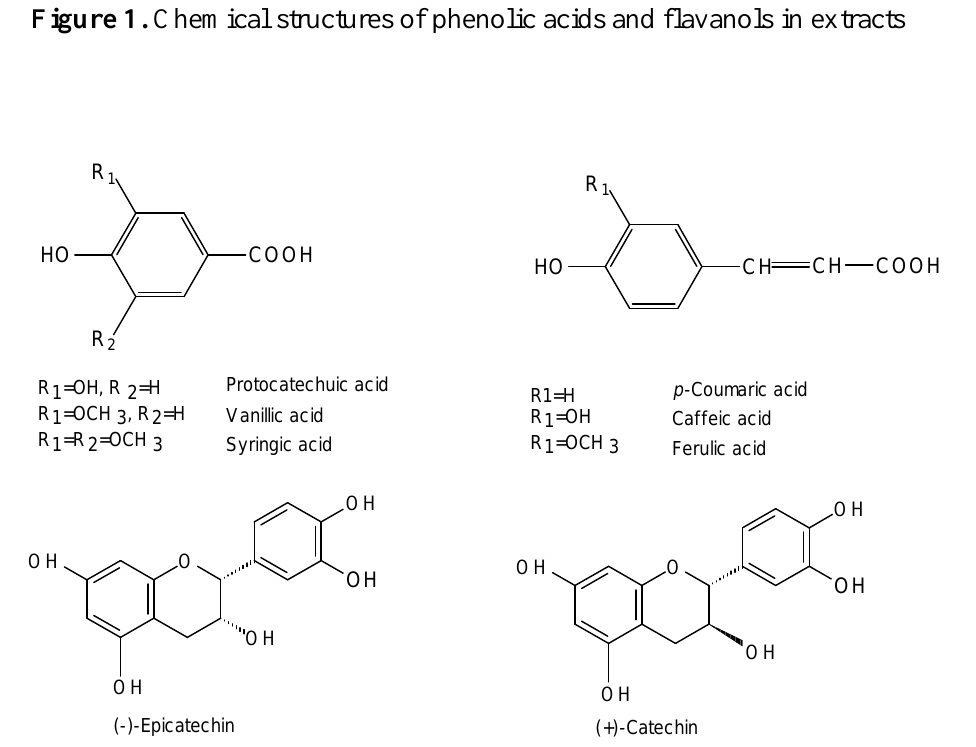
Figure 1. Chemical structures of phenolic acids and flavanols in